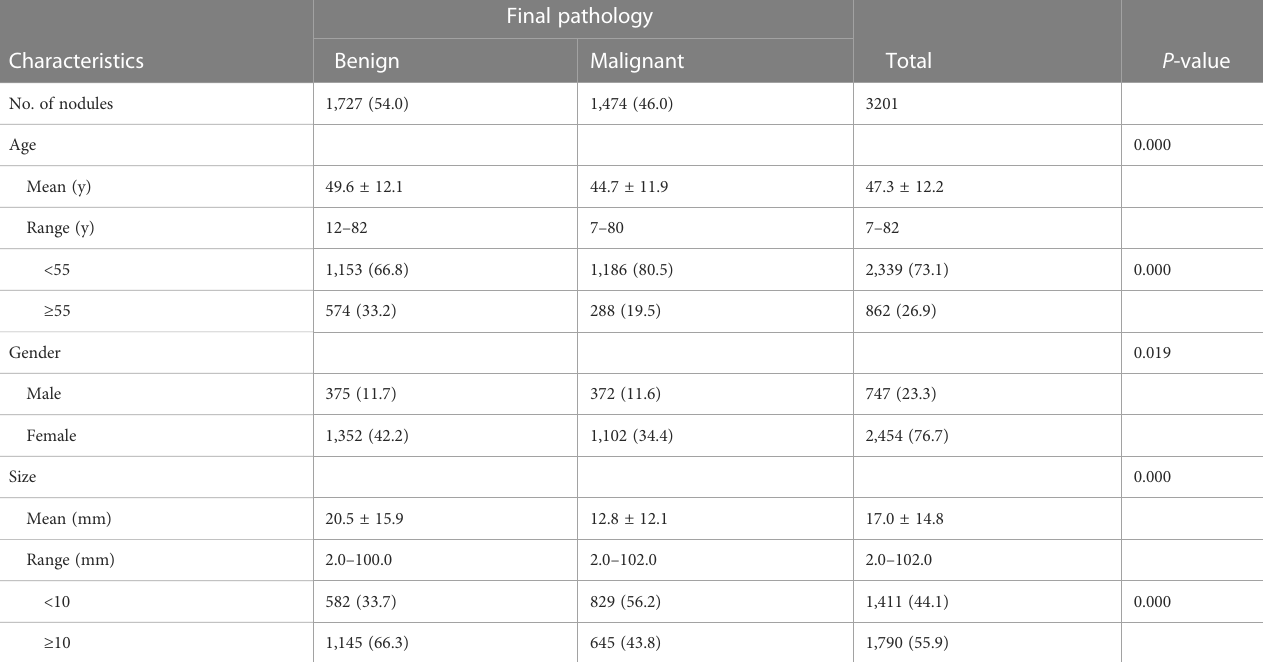
TABLE 2 Summary of demographic and ultrasound (US) features for the patients with thyroid nodules.